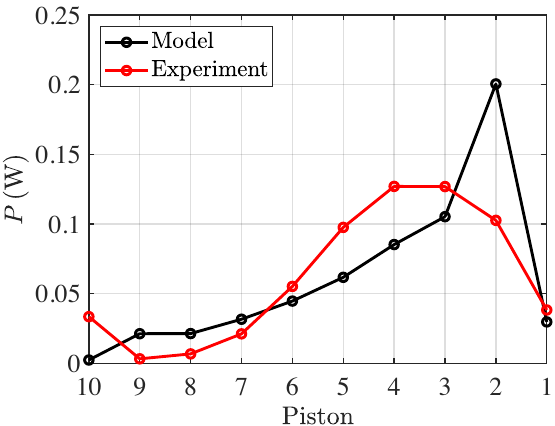
Figure 11. Extracted power by the single pistons for the mathematical and experimental models. Connecting lines are for graphical illustration